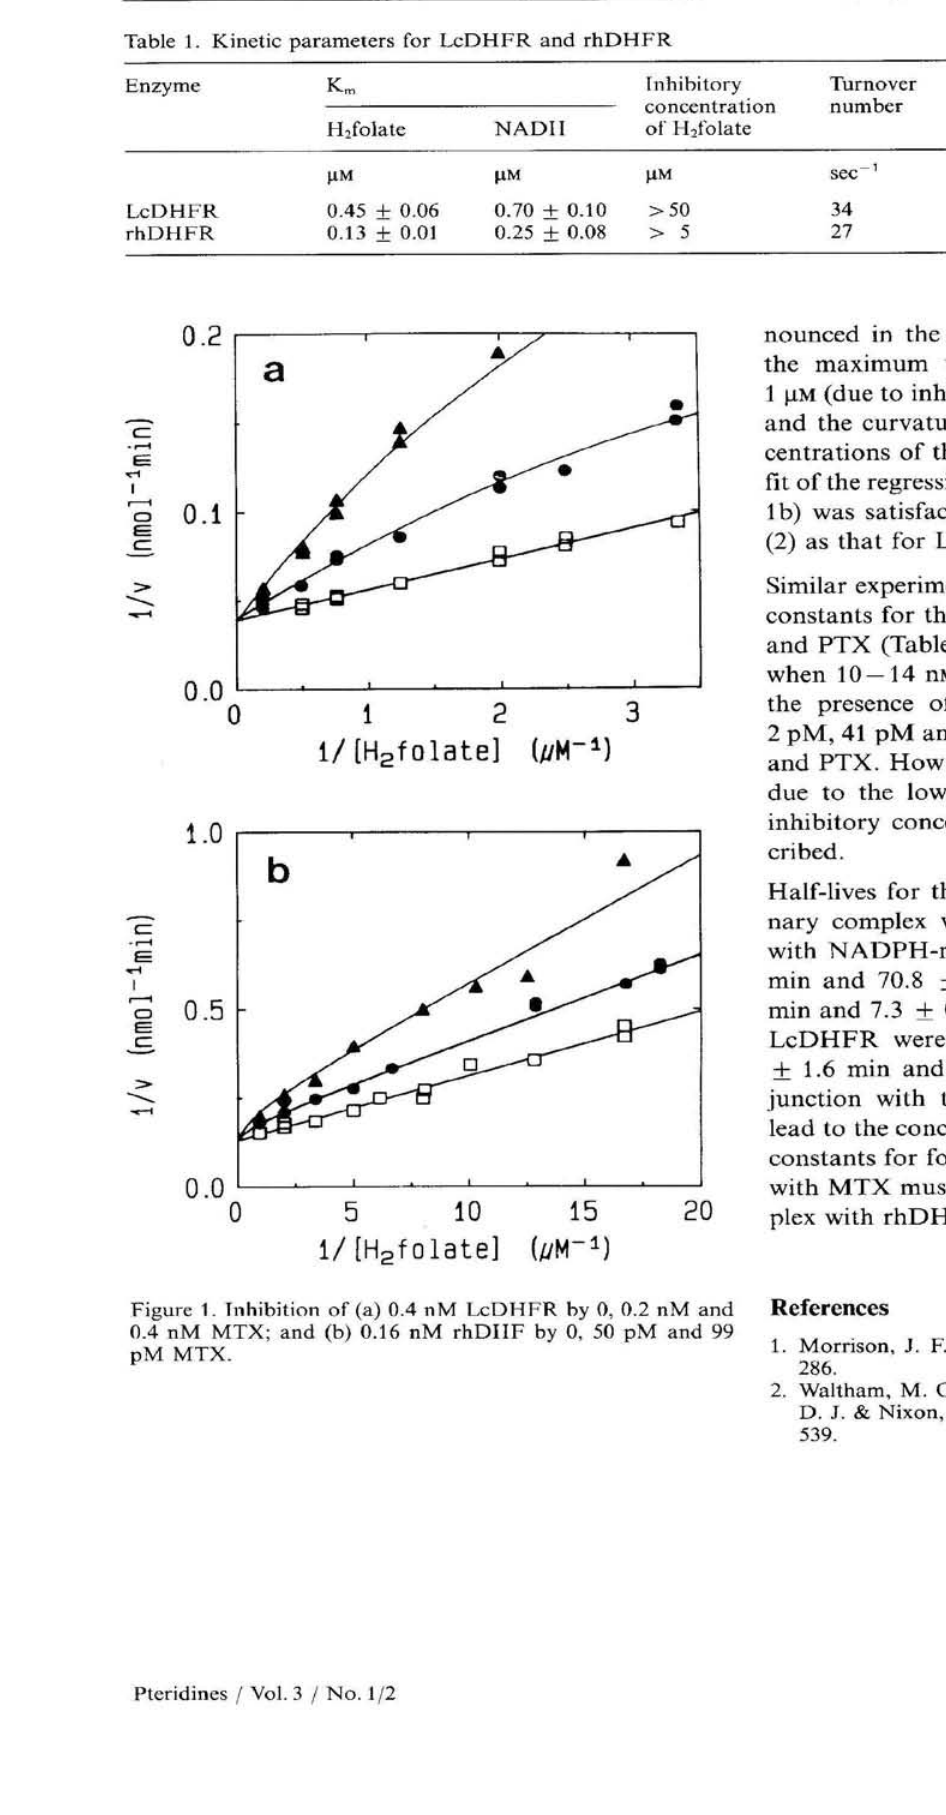
Table 1. Kinetic parameters for LcDHFR and rhDHFR